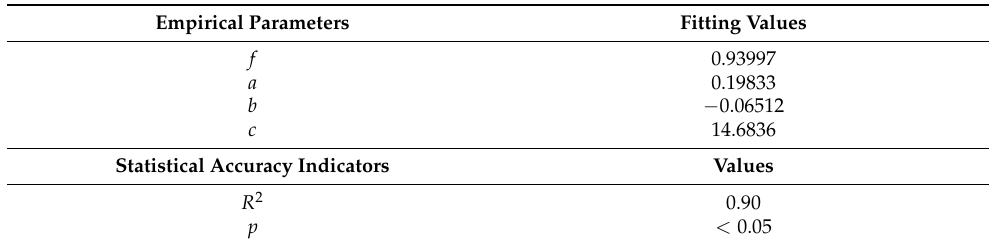
Table 4. Quantitative values of empirical parameters to predict Nu from Ha and Da numbers at (cid:101) = 0.4, θ = 45, and Ra = 10 4 .